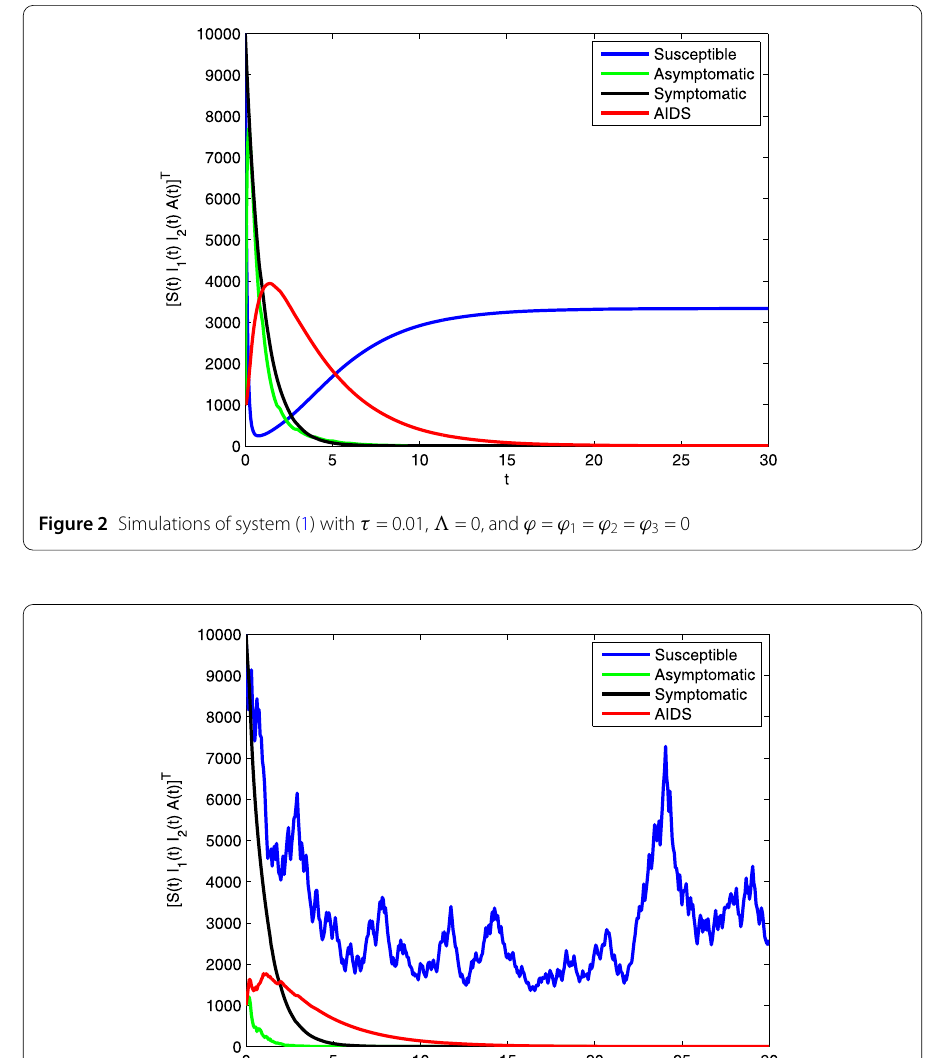
(III) In the absence of time delay, the amplitude of bounded noise (cid:7) = 0.1, the center frequency of bounded noise (cid:8) = 0.2, and the intensity of noises ϕ = ϕ 1 = ϕ 2 = ϕ 3 = 0.5.